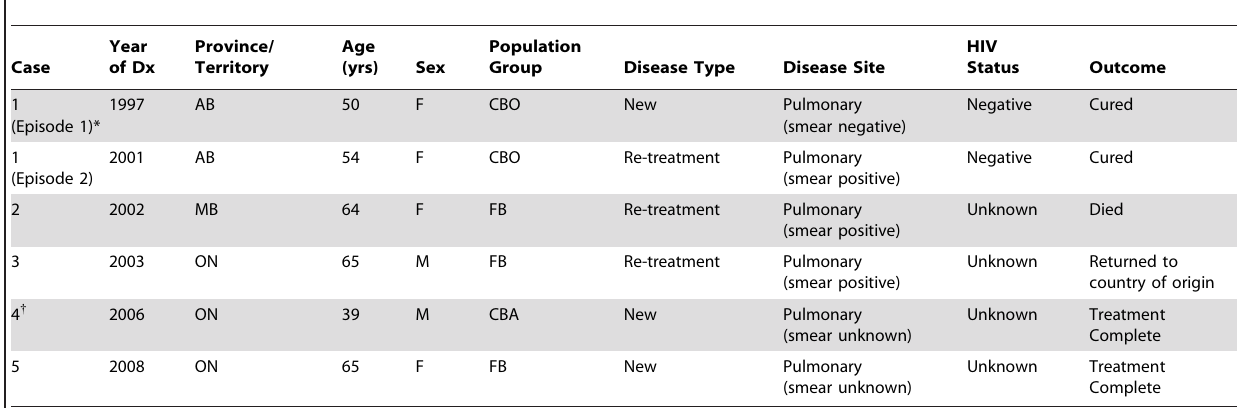
Table 5. XDR tuberculosis in Canada (1997–2008): demographic features and case